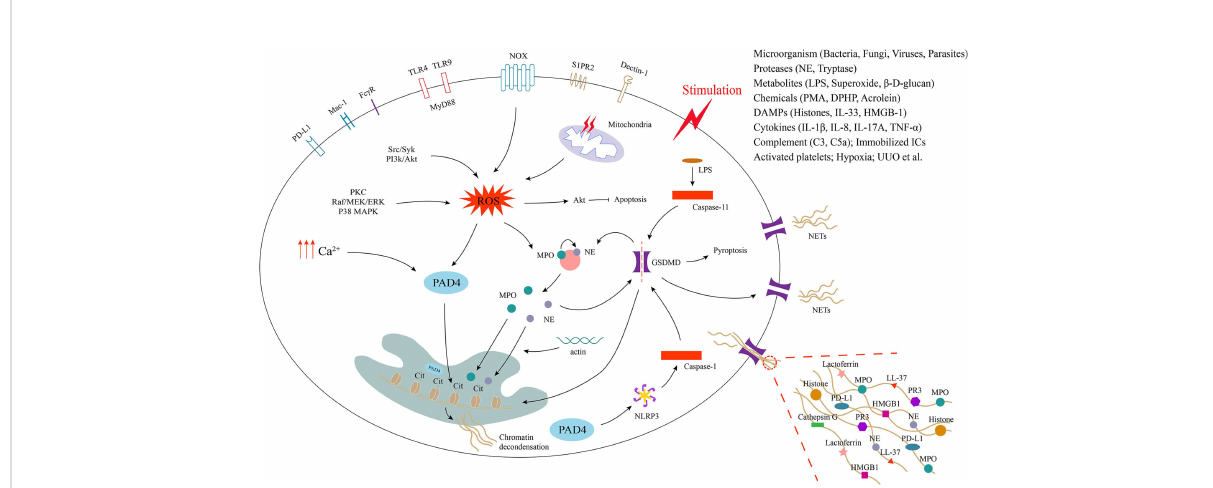
FIGURE 1 Process of neutrophil extracellular trap formation and underlying cellular and molecular mechanisms. Neutrophils release extracellular traps (NETs) by different mechanisms in response to different stimuli. Activation of neutrophil surface receptors NOX (nicotinamide adenine dinucleotide phosphate oxidase), TLRs (Toll-like receptors), Fc g R (Fc gamma receptor), Mac-1 (macrophage-1 antigen), PD-L1 (programmed death ligand 1), S1PR2 and dectin-1 is involved in NET formation. The generation of ROS (reactive oxygen species) and intracellular calcium promotes the activation of PAD4 (peptidyl arginine deiminase 4), which promotes histone citrullination in the nucleus and induces chromatin decondensation. ROS production also promotes the release of MPO (myeloperoxidase) and NE (neutrophil elastase) from neutrophil granules, which enter the nucleus with the assistance of actin and also facilitate chromatin decondensation. NE and caspase-1/11 can activate GSDMD (gasdermin D), which translocated to the cell membrane to form pores, leading to membrane rupture and release of NETs decorated with various proteins such as MPO, NE, histones and more to the extracellular